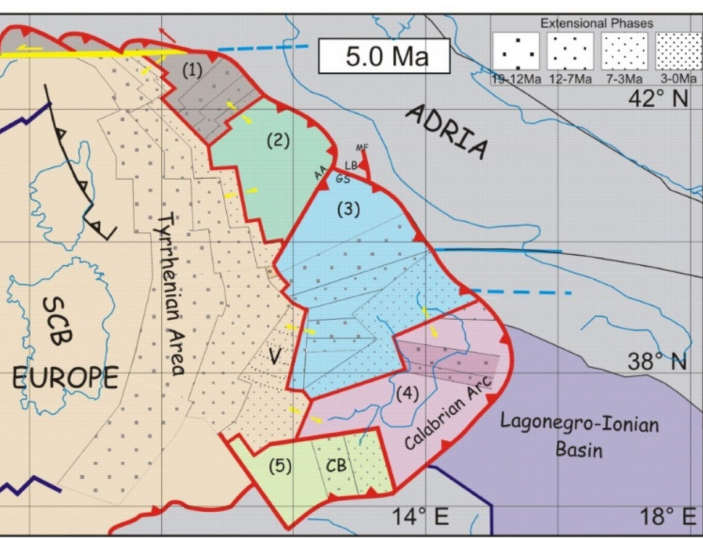
Figure 26. Plate reconstruction of the western Mediterranean region at 5 Ma. The Northern Sector ( 1 ) is shown in ( dark beige ); the Central Sector ( 2 ) is in ( green ); the Southern Sector ( 3 ) is in ( light blue ); the Calabrian Arc Sector ( 4 ) is in ( pink ), the Sicilian Sector in ( light green ) ( 5 ). ( Dotted areas ) are in extension (see upper right legend). ( Red lines ) are active boundaries. ( Black lines ) are inactive boundaries. ( Yellow lines ) are strike-slip faults. ( Light blue lines ) are transfer faults on the continental lithosphere. ( Dark blue lines ) are the Middle-Triassic COB. ( Red arrows ) are the velocity vectors between Adria and the adjacent sector. AA: Ancona-Anzio line; CB: Caltanissetta Basin; GS: Gran Sasso Front; LB: Laga Basin; MF: Montagna dei Fiori, SCB: Sardinian-Corsican block; V: Vavilov basin.